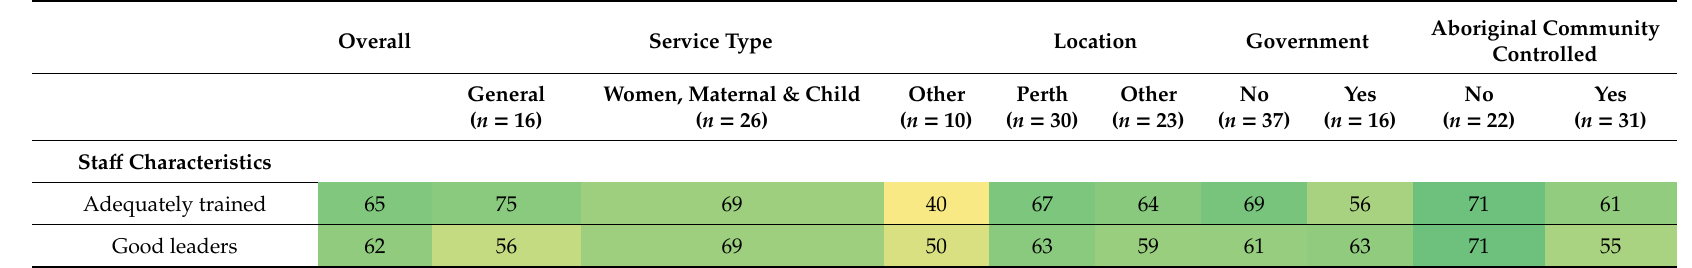
Table 4. Barriers and facilitators in providing good service by service type, location of service, and governance structure (%). Overall Service